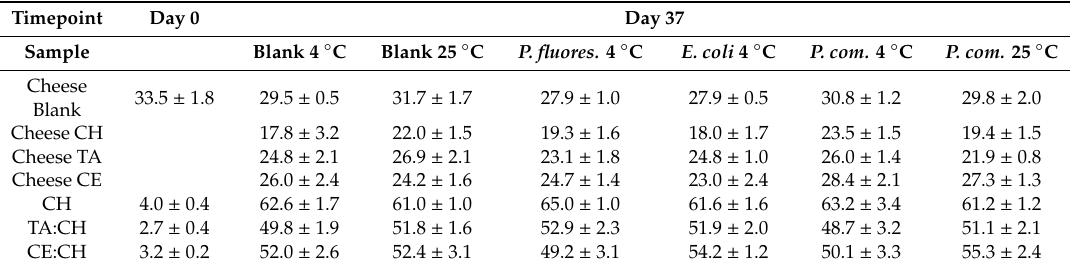
Table 2. The e ff ect of biopolymer films (CH, TA:CH, CE:CH) on cheese (cid:48) s moisture content (MC) compared to moisture accumulation in films (both in % per 0.5 g). Values are means ( n = 2 × 2) with standard errors, which within a row are significantly di ff erent ( p <